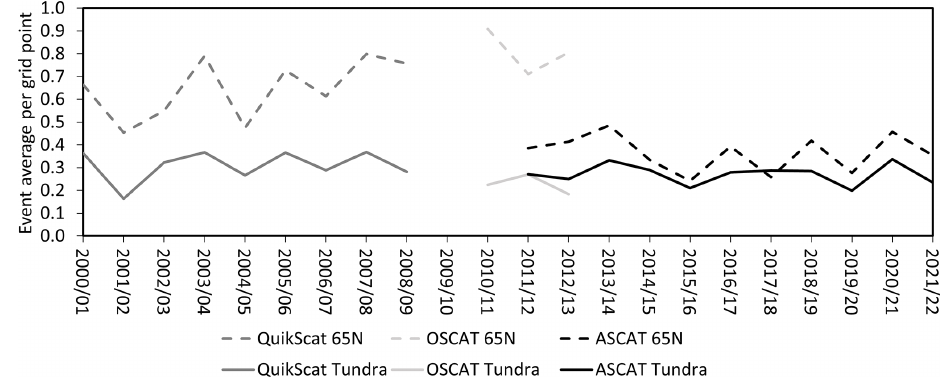
Figure 9. Average potential high-latitude ROS events per winter and grid cell (resampled to QuikSCAT 10 × 10km grid) for overlap area are north of 65 ◦ N (excludes Greenland and masked areas in the ASCAT–SMOS results), as well as for tundra only (extent source: CAVM; Raynolds et al.,